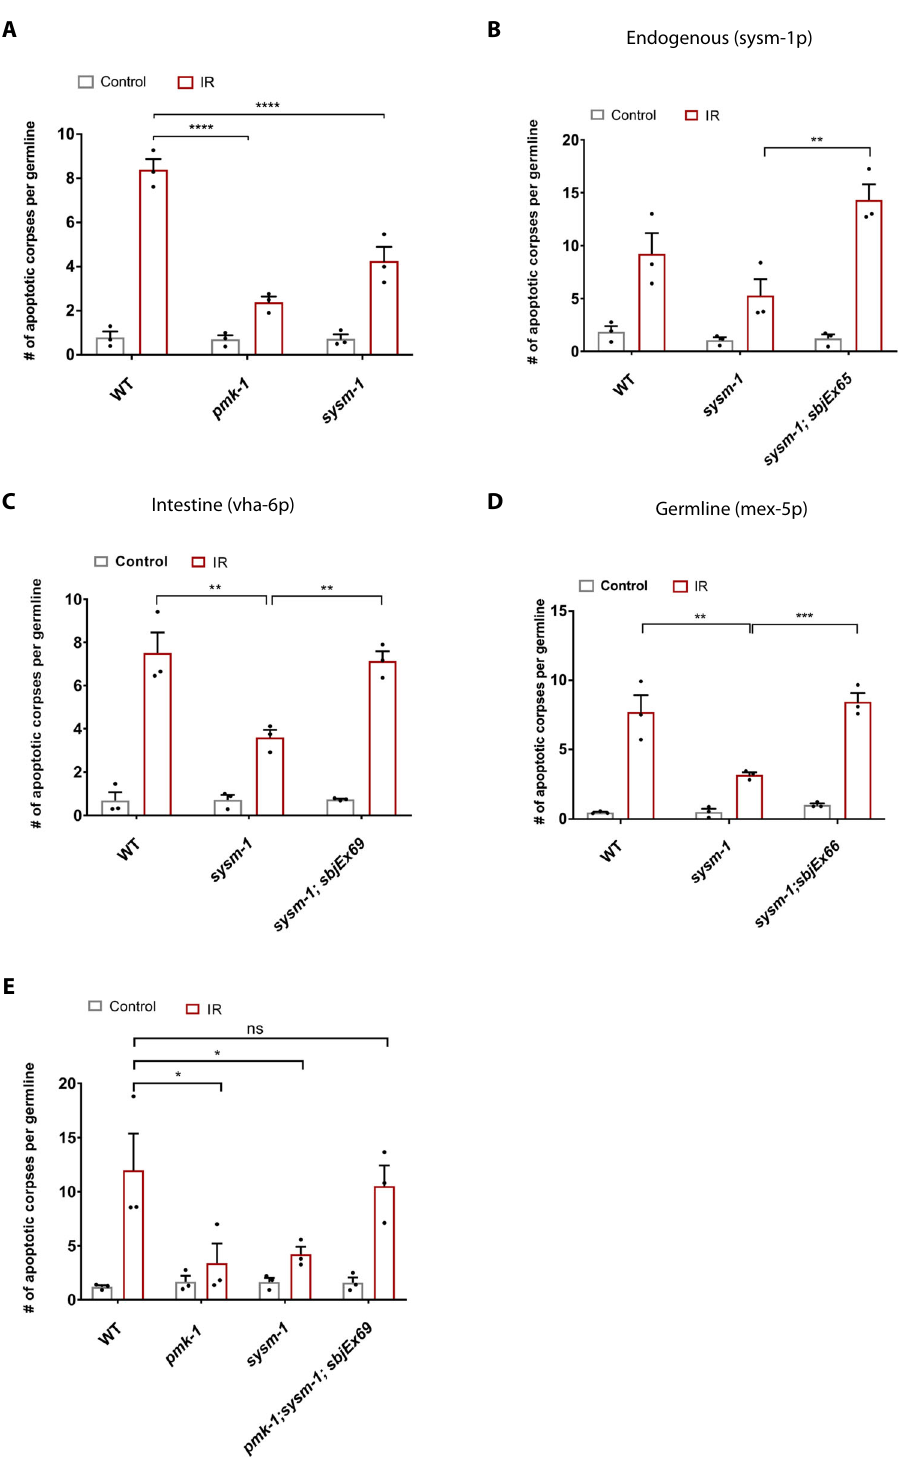
Fig. 2 PMK-1/p38 target SYSM-1 regulates germ cell apoptosis non-cell-autonomously. A sysm-1(ok3236) mutants are defective in inducing apoptosis upon IR treatment similarly to pmk-1(km25) mutants. B Endogenous-, C intestine-, and D germline-speci fi c expression of SYSM-1 rescues the apoptosis defect in sysm-1(ok3236) mutant worms in response to IR. E Intestine-speci fi c expression of SYSM-1 suppresses the apoptotic defect of pmk-1 mutants. The graphs A – E display n = 3 independent experiments and each dot indicates one independent experiment that includes 8 – 20 germlines per condition scored 6 h post-IR (90 Gy). Error bars show mean ± s.e.m. (Two-way ANOVA with Tukey ’ s multiple comparison test. A WT(IR) : pmk-1(IR) **** p < 0.0001, WT(IR) : sysm-1(IR) **** p < 0.0001, B sysm-1(IR):sysm-1;sbjEx65(IR) ** p = 0.0022, C WT(IR) : sysm-1(IR) ** p = 0.0011, sysm-1(IR):sysm-1;sbjEx69(IR) ** p = 0.0026, D WT(IR) : sysm-1(IR) ** p = 0.0013, sysm-1(IR):sysm-1;sbjEx66(IR) *** p = 0.0003, E WT(IR) : pmk-1(IR) * p = 0.0231, WT(IR) :